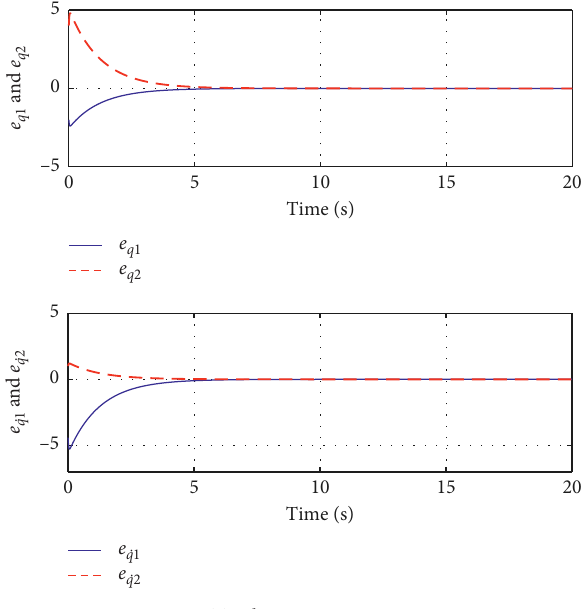
Figure 5: Tracking error convergence.